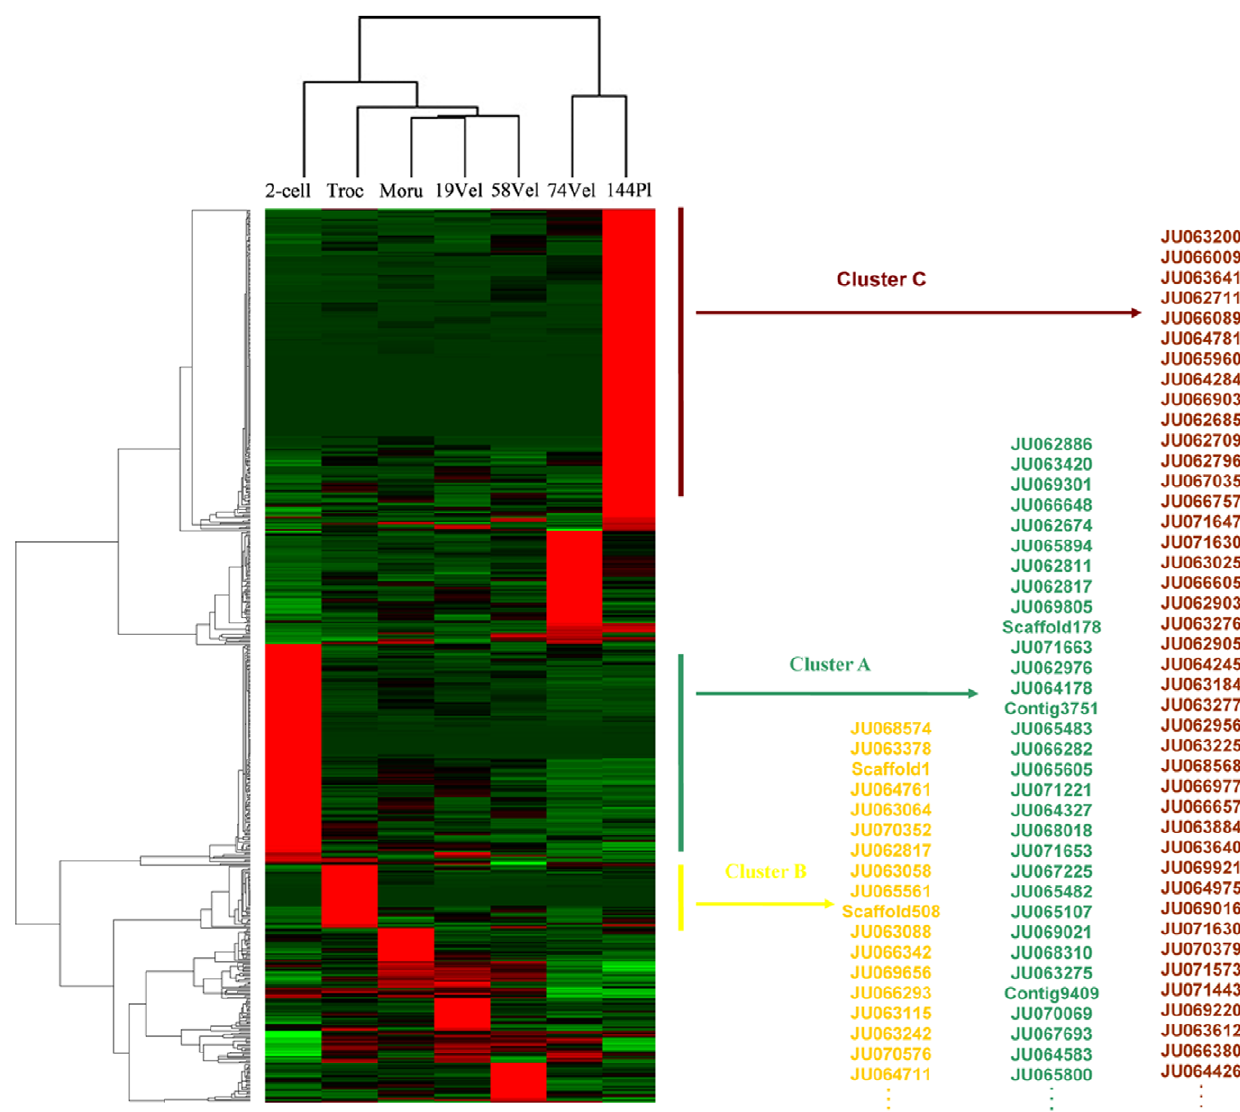
Figure 6. Clusters of the expression levels of the candidate genes. Dendrograms of the gene expression patterns for the 636 genes assigned 2 or more stars are shown. The clustering indicates similar expression patterns among the developmental stages (x-axis) and among the genes (y- axis). The bar color reflects the gene expression level from green (low) to black (medium) to red (high). The partial gene names used for the analysis, whose expression levels were extremely high during the two-cell, trochophore and 144 postlarval stages, are displayed in the chart. The gene IDs in these three clusters are listed in Table S3.